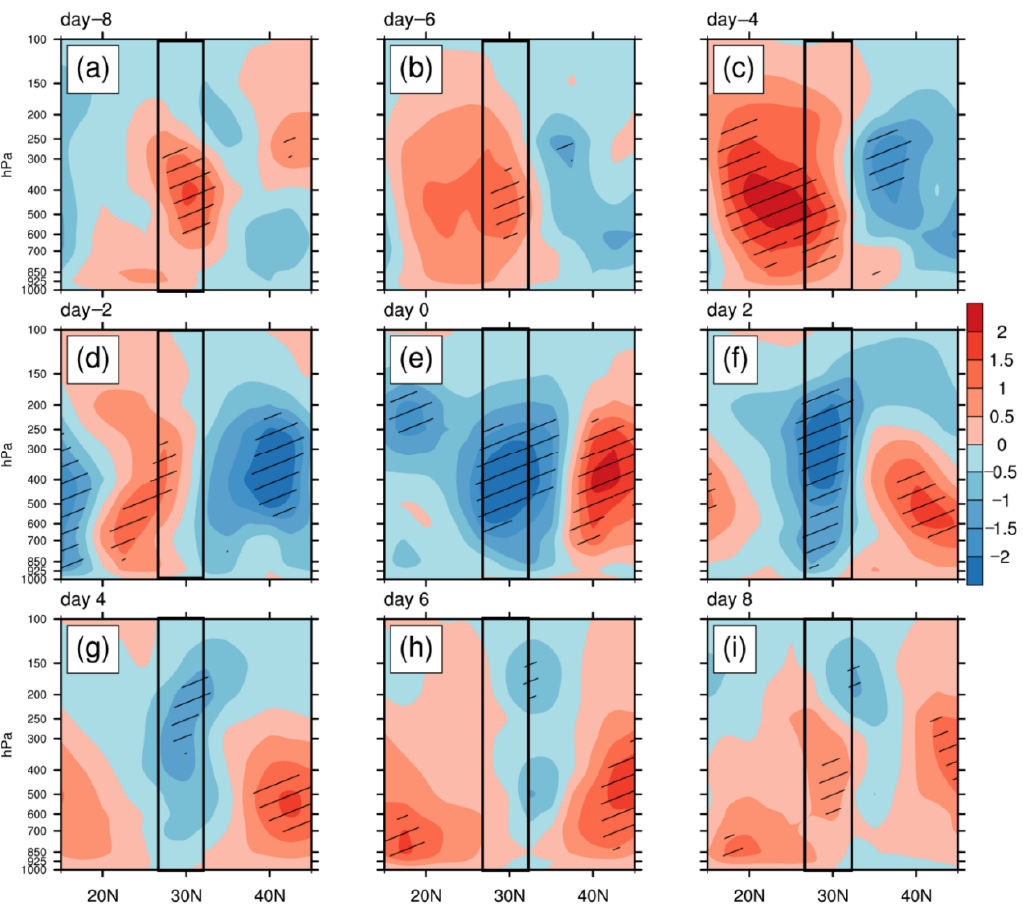
Figure 14. The same as in Figure 11, but for the SRP− events.